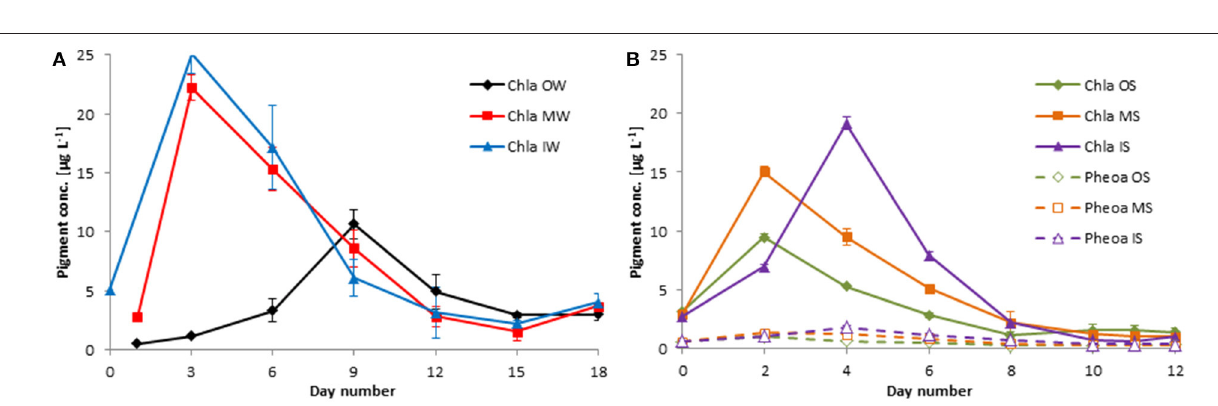
FIGURE 9 | Development of the chl a concentrations in winter 2013 (A) and of the chl a and pheo a concentrations in summer 2014 (B). Mean values and standard deviations of the three replicate tanks are